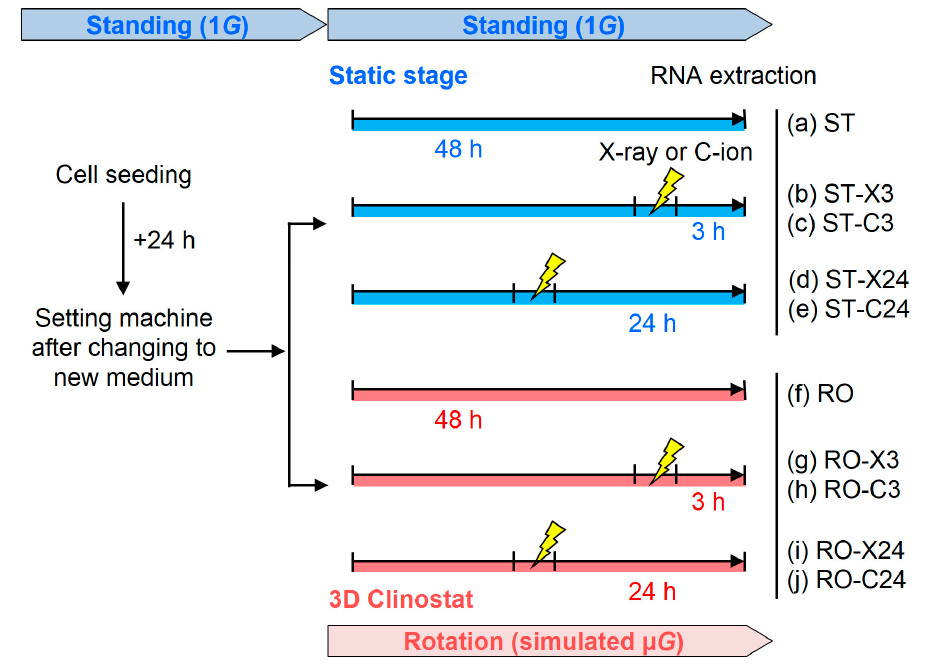
Figure 6. Experimental design from cell seeding to RNA extraction using human fibroblasts. ST ( a–e ) and RO conditions ( f–j ). No irradiation ( a,f ), X-ray ( b,d,g,i ), or C-ion ( c,e,h,j ) irradiation.